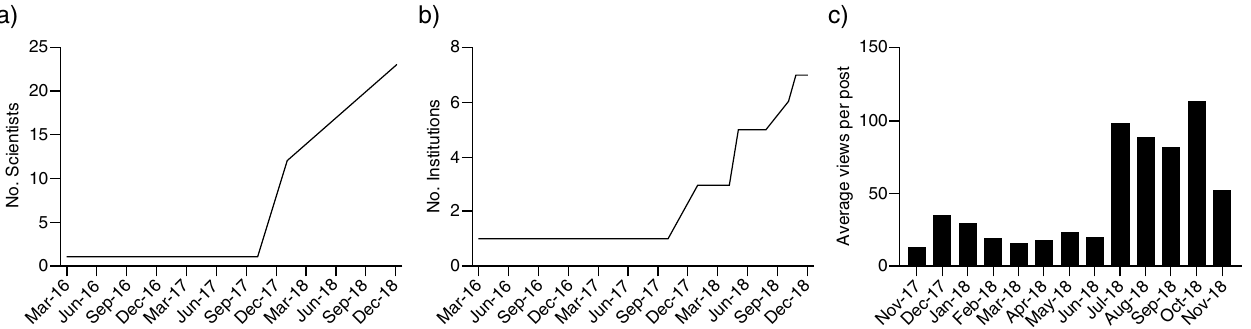
Figure 3. Information on openlabnotebooks.org. The Number of ( a ) scientists and ( b ) institutions actively contributing to openlabnotebooks.org. ( c ) The average number of unique visits for each experimental